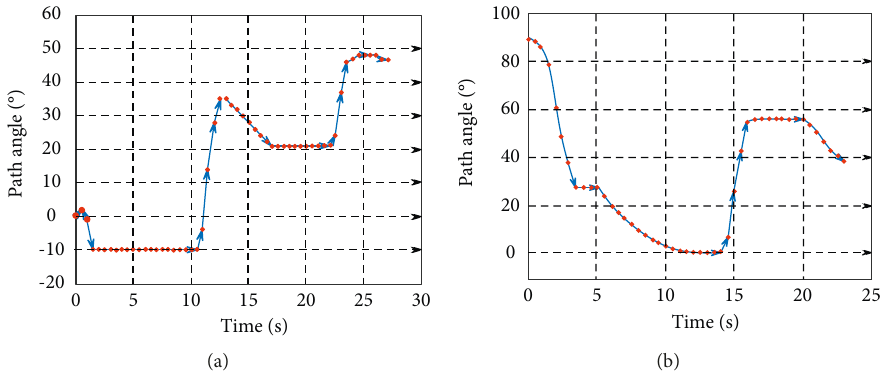
Figure 10: Changes in angle. (a) Initial orientation angle of 0 ° , target location (300, 100). (b) Initial orientation angle of 90 ° , target location (210,